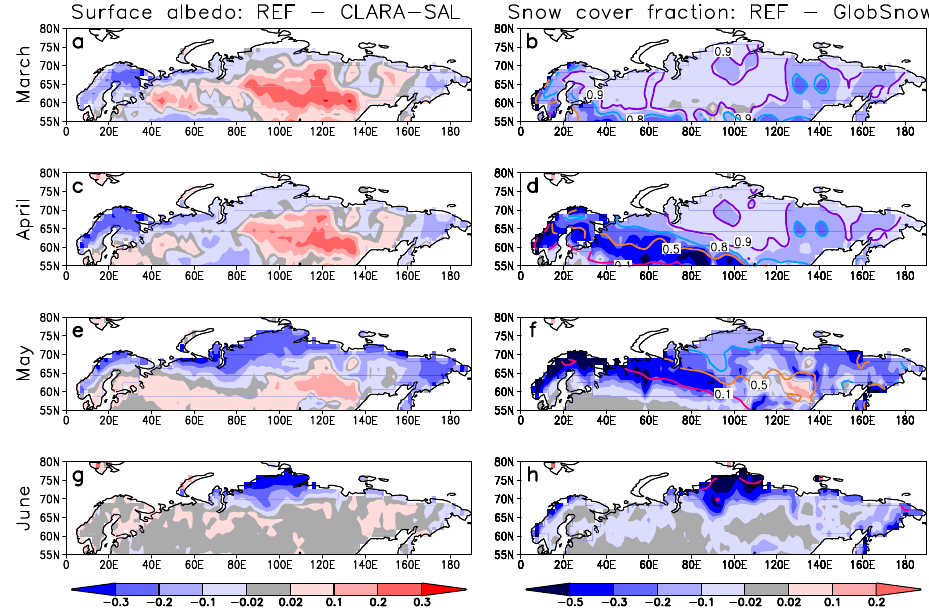
Figure 6. (a, c, e, g) Differences in surface albedo for years 1982–2006 between the REF experiment and the CLARA-SAL data set for the months of March, April, May, and June. (b, d, f, h) Corresponding differences in snow cover fraction for years 1997–2006 (excluding 2002) between the REF experiment and the GlobSnow data set. The coloured contours (magenta = 0.1; orange = 0.5; blue = 0.8; and violet = 0.9) indicate the snow cover fraction in